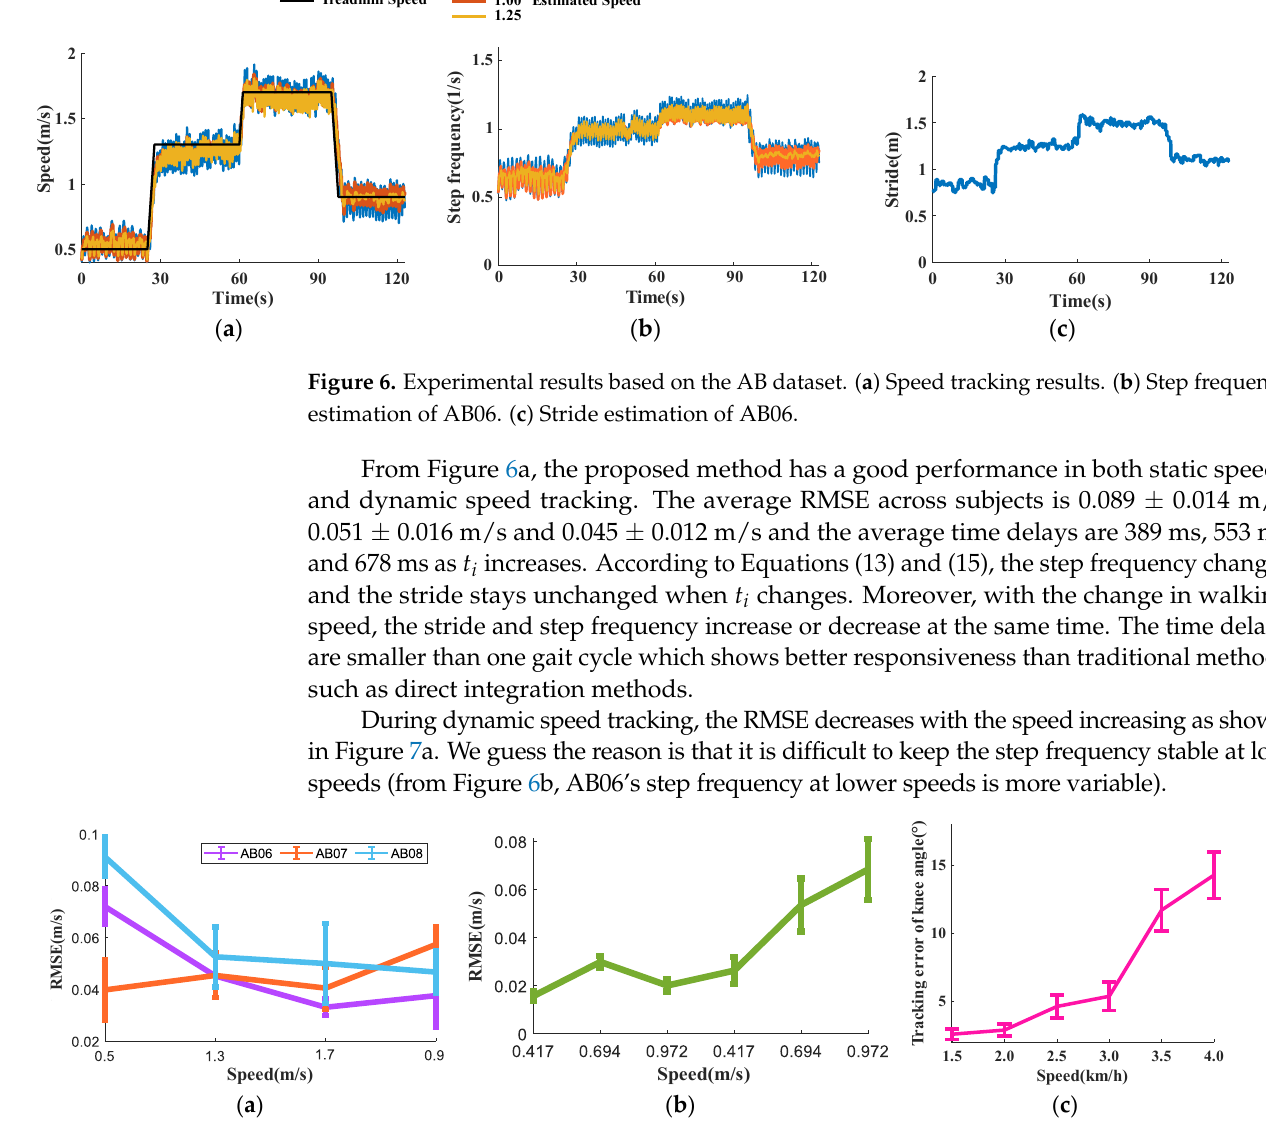
Figure 7. ( a ) Speed estimation errors at different speeds based on the AB dataset; ( b ) Speed estimation errors at different speeds based on the PW dataset. ( c ) Tracking errors of prosthetic knee angle when subjects are equipped with the lower-limb prosthesis and walk at different speeds. The error band represents one standard deviation.